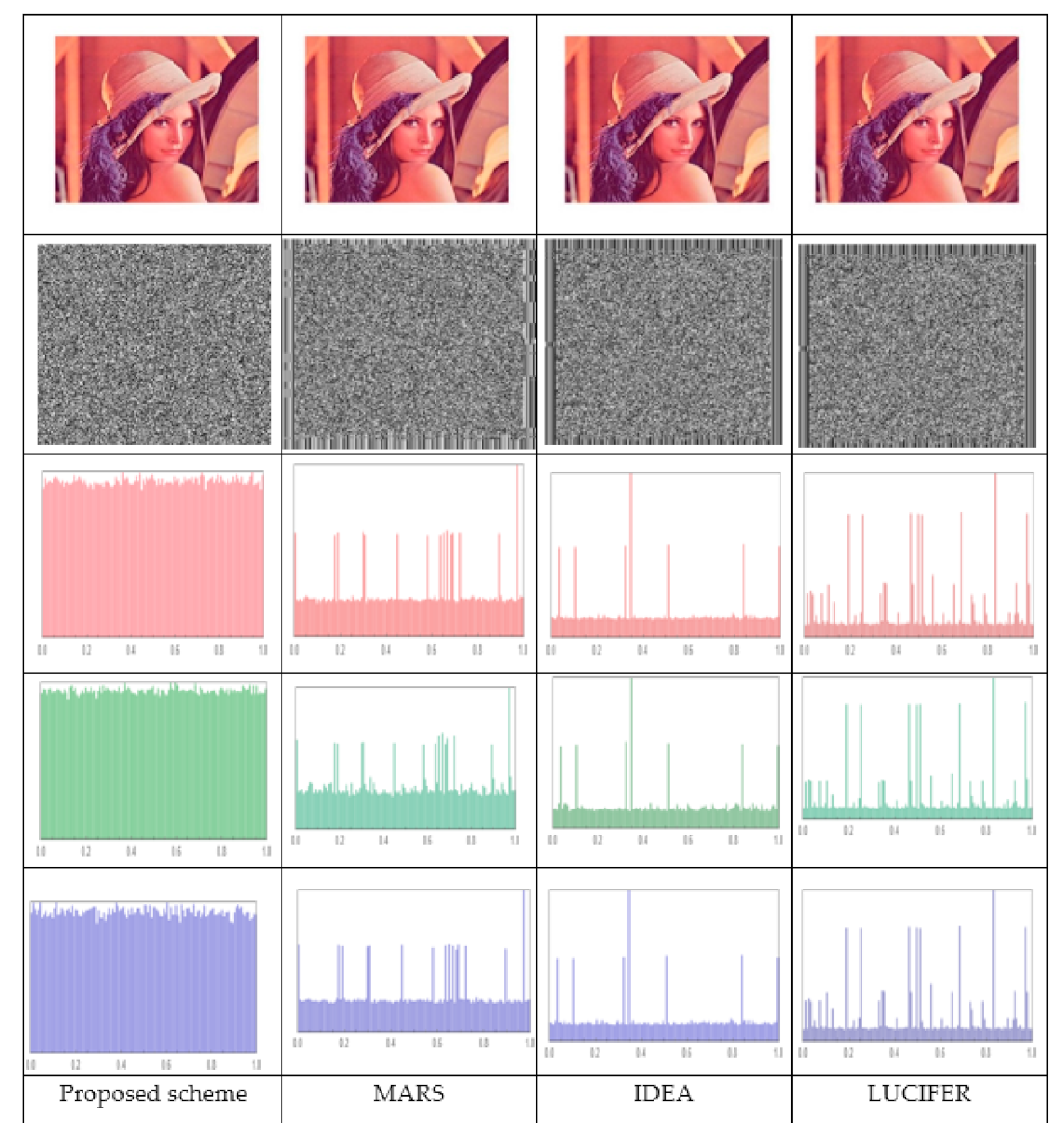
Figure 11. Histograms of plaintext Lena’s image and cipher image for proposed scheme, MARS, IDEA, and